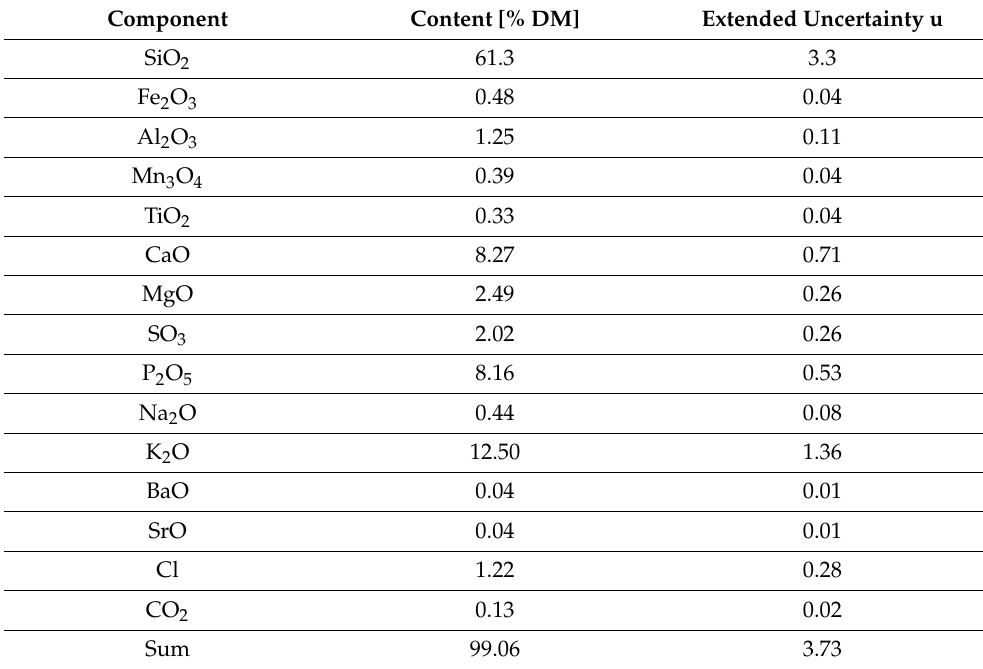
Table 5. Composition of ash from the combustion of a giant miscanthus